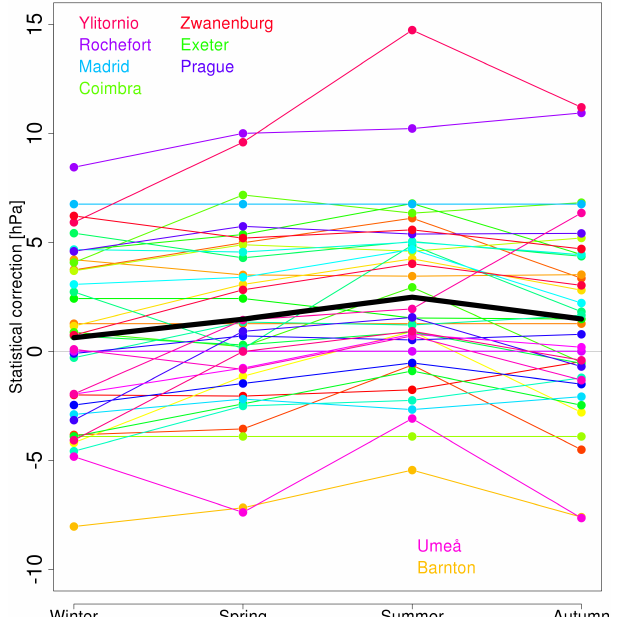
Figure 8. Seasonal corrections applied for the case studies. Each colour represents a different station in Europe; the thick black line is the average of all corrections. The names of the stations with mean absolute corrections larger than 5hPa are also printed.